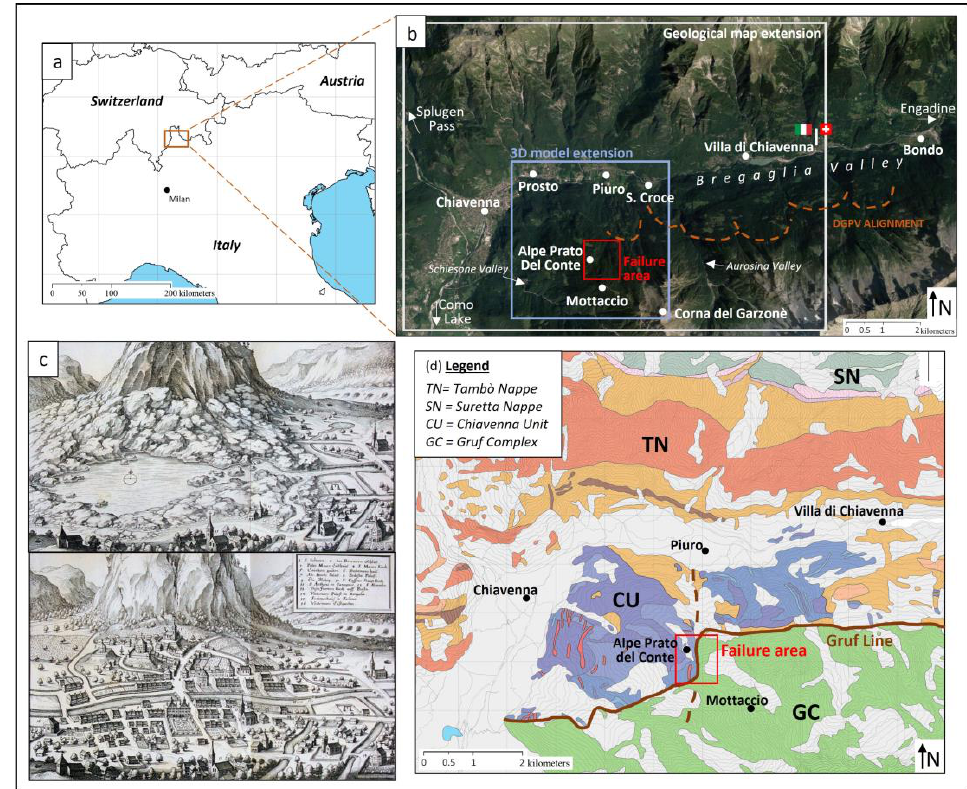
Figure 1. ( a ) Location of the study area; ( b ) Satellite photo of the study area showing the location of the failure area, the extent of the 3D model, and geomorphological features characterizing the Valley; ( c ) Historical drawings showing the village of Piuro before and after the 1618 event [2]; ( d ) Geological settings of the Italian Bregaglia Valley (from CROP project, [46]); geological cross section are reported in [3].